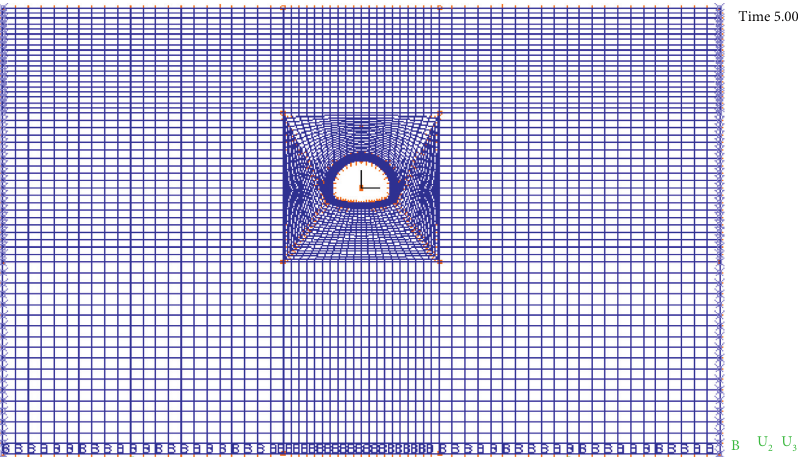
Figure 3: Dynamic analysis model.